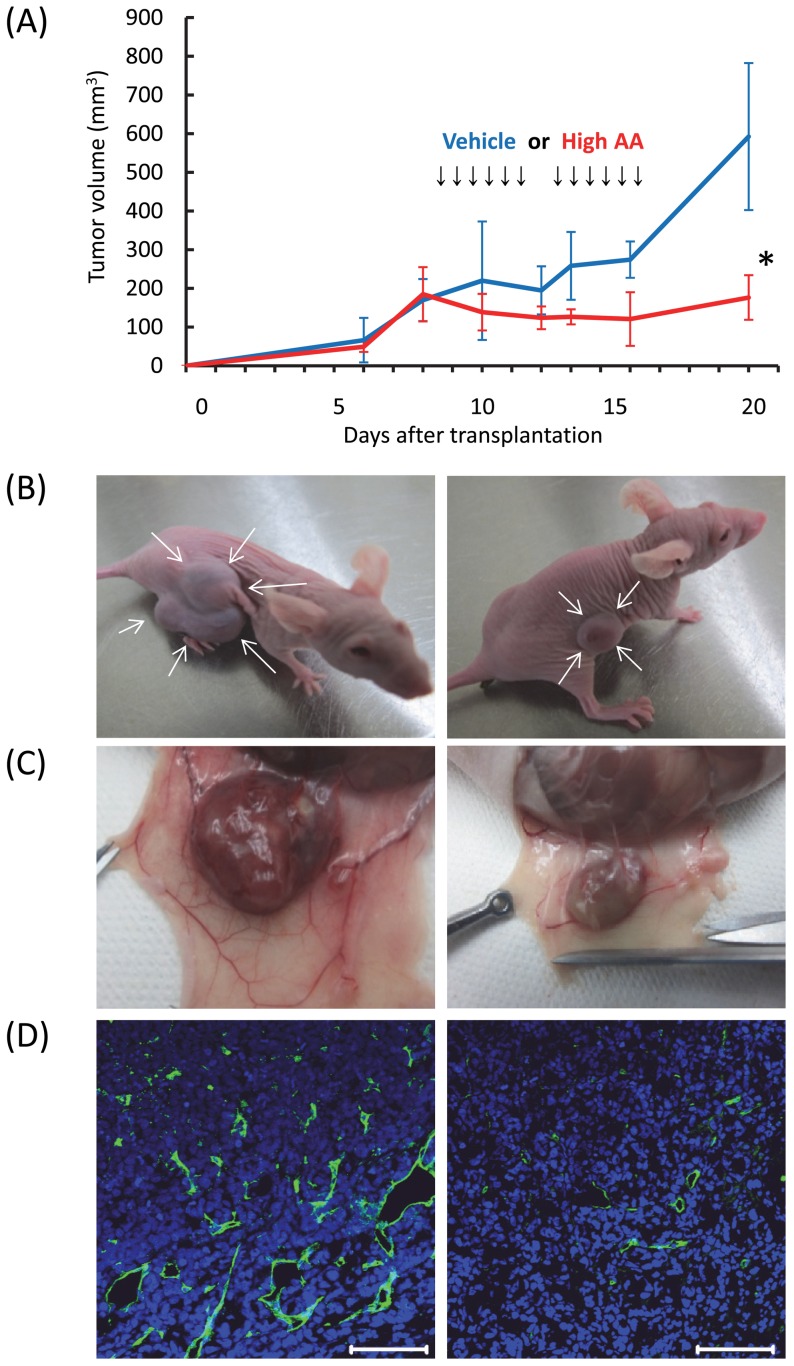
In vivo effects of high AA on progression of leukemia.A) High AA or the vehicle was injected intravenously for 6 days with a rest period of 2 days between 3 daily injections of mice transplanted with HL60 cells. Compared with vehicle (blue line), high AA (red line) significantly inhibited tumor growth (*P<0.01). The values represent the mean ± SD values of 5 mice. B) Appearance of mice treated with vehicle (left) and high AA (right), 4 days after the final injection. C) Representative macroscopic appearance of tumors of mice treated with the vehicle (left) and high AA (right). Note that the tumors of high AA-treated mice were smaller and less erythematous than those of vehicle-treated mice. D) Immunohistochemical analysis of tumor neoangiogenesis in mice treated with the vehicle (left) and high AA (right). The green and blue signals represent CD31 and 4′,6-diamidino-2-phenylindole (DAPI), respectively. The bars indicate 100 μm.